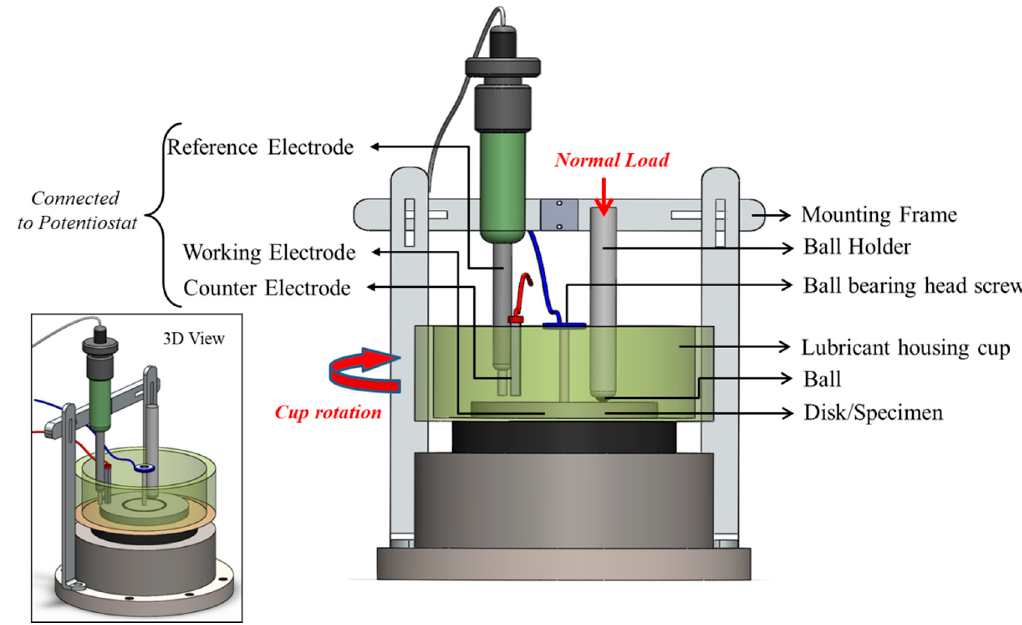
Figure 3. Schematic of ball-on disk test rig retrofitted with a three-electrode corrosion cell.